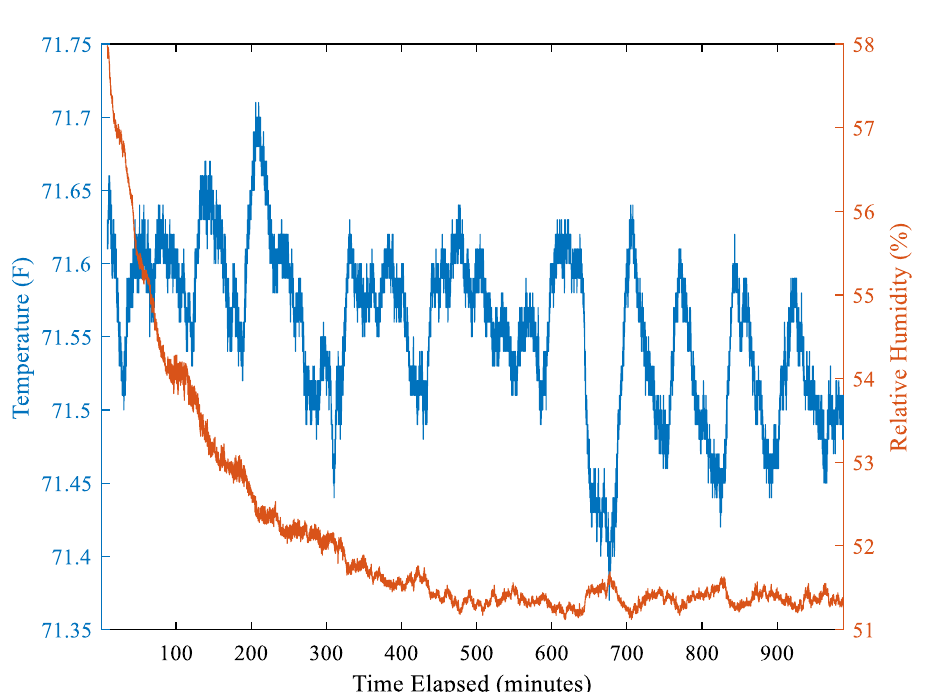
Figure 4. Example compensation for humidity drop starting at 58% and decreasing to 51% over 8 h with stability for additional 8